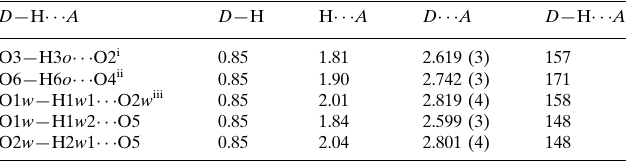
Hydrogen-bond geometry (A˚ , (cid:2)